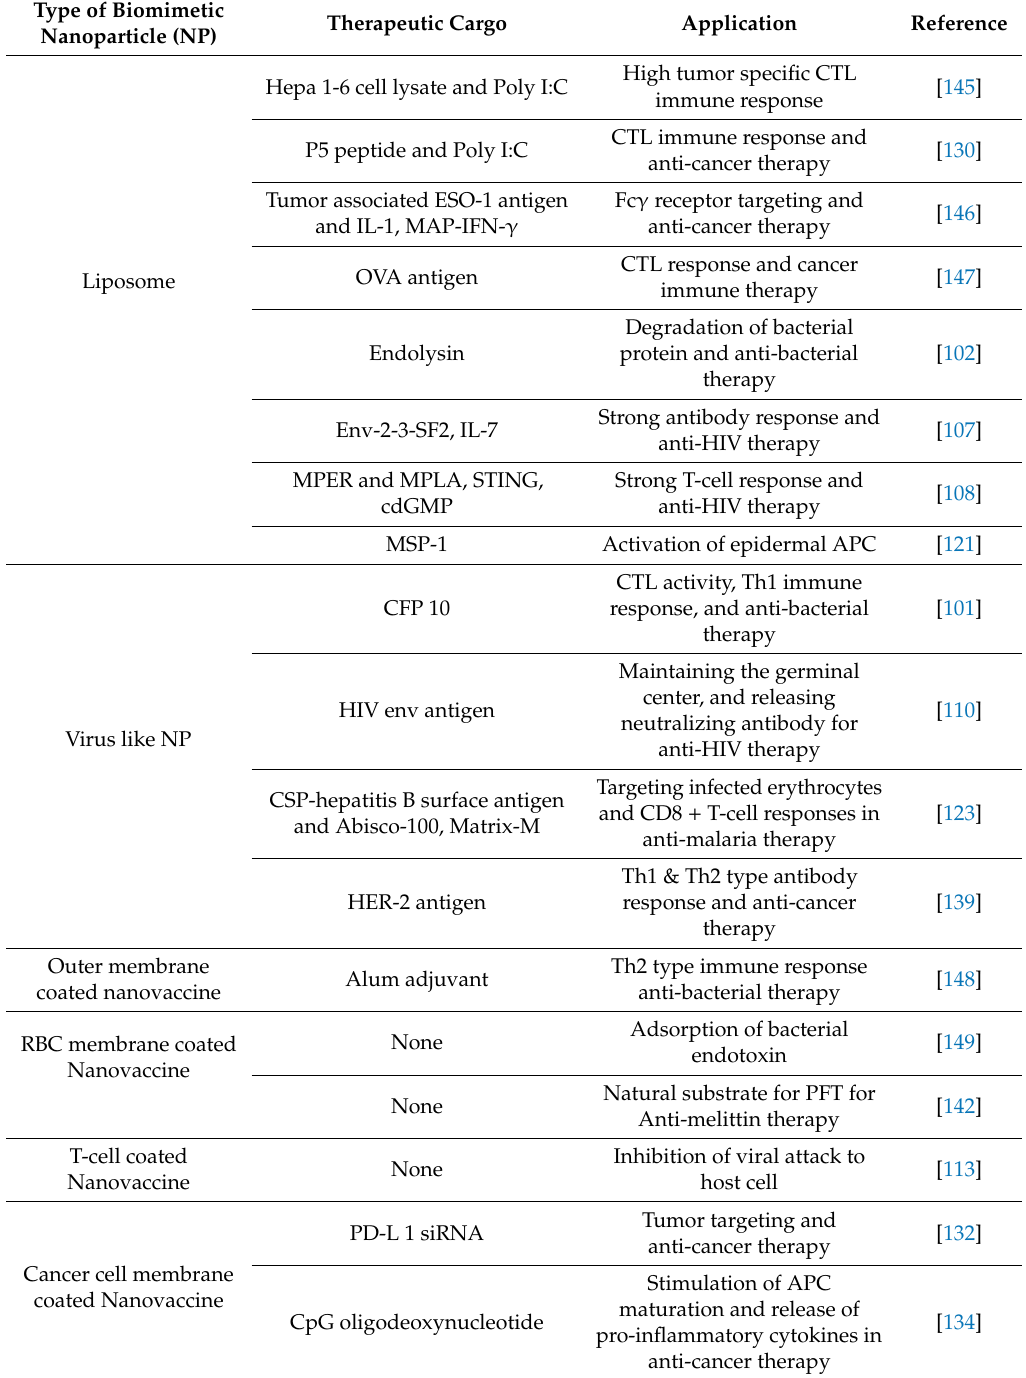
Table 3. List of biomimetic nanovaccines for various